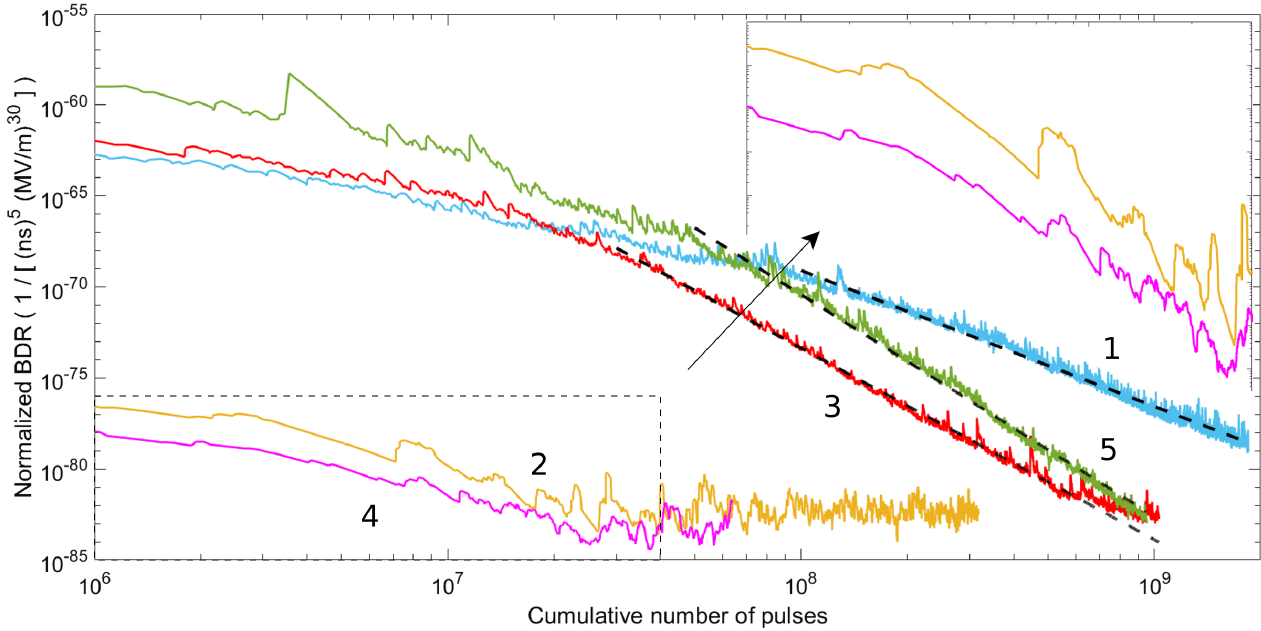
FIG. 3. Normalized breakdown rate [Eq. (2)] over the course of all measurement runs (numbered in the figure according to the sample), along with fits for the conditioning gradient for the soft samples 1, 3, and 5. For sample 3, the fit is plotted beyond the fit range to show the divergence from power law due to saturation. Unit of normalized BDR chosen consistently with other work [20]. An enlargement of the dashed area is provided to better show the downward concave shape of the conditioning progress of the hard samples 2 and